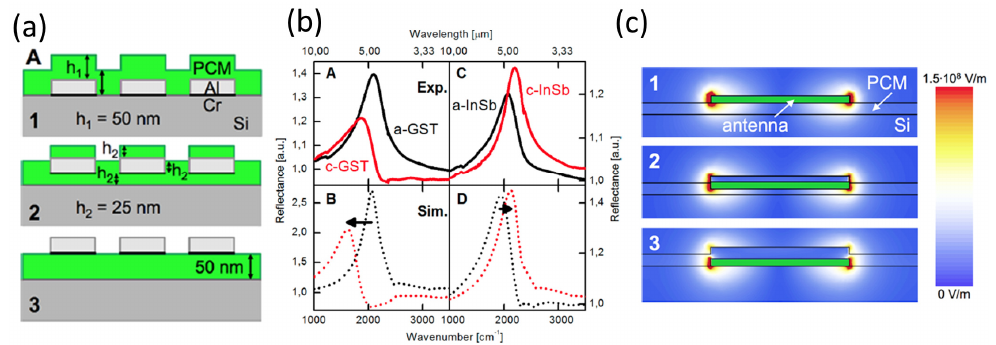
Figure 5. GST-based resonance antenna. ( a ) Schematic graph of the designed nanoantennas below, amongst, and on top of the GST layer; ( b ) Measured and simulated reflectance spectra for the amorphous and crystalline GST layer; ( c ) The first resonant field distribution for various types of the designs below, inside and on top of the GST film. Adapted from [12], with permission from © 2013 American Chemical